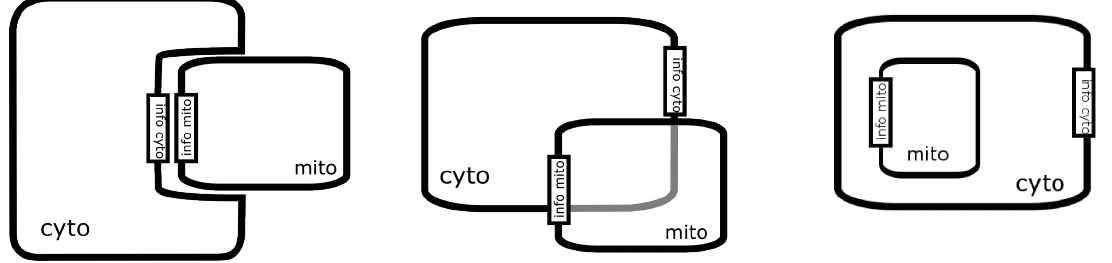
Figure 2.10: Overlapped compartments are permitted, but the overlap does not imply con- tainment.